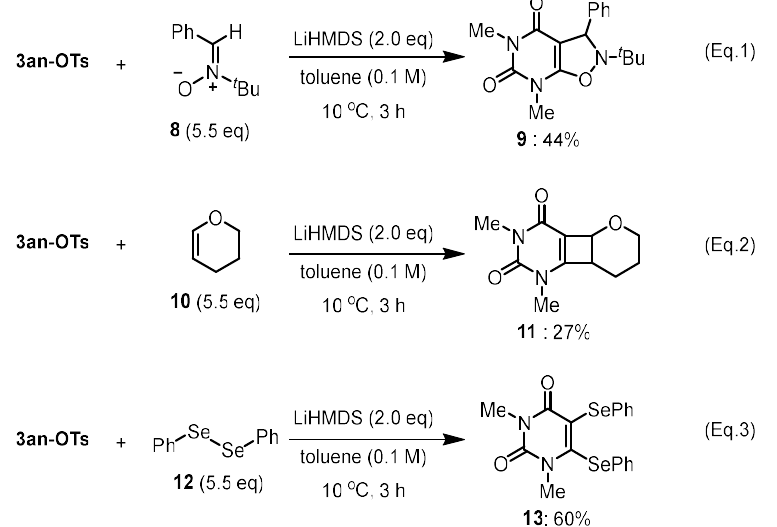
Figure 2. Reported heteroarynes and uracil-heteroaryne analog 14 .